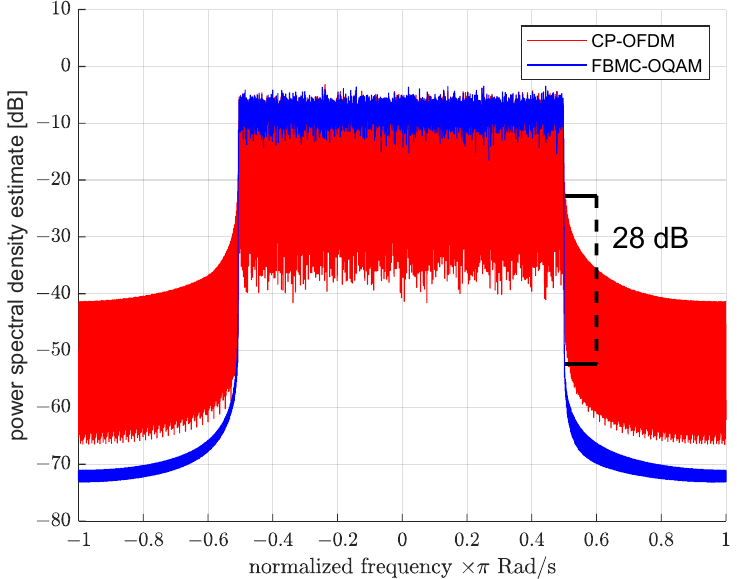
Figure 2. FBMC-OQAM and CP-OFDM power spectral density comparison.